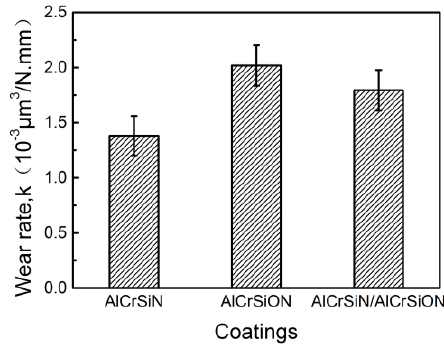
Figure 11. Wear rates of the AlCrSiN coating, AlCrSiON coating, and AlCrSiN/AlCrSiON duplex coating.